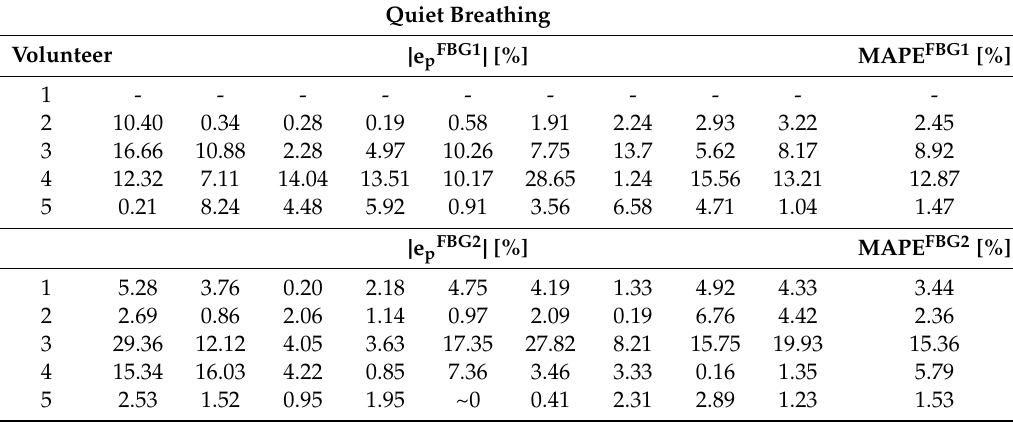
Table 3. Breath-by-breath absolute percentage errors, | e p | , and mean absolute percentage error (MAPE)